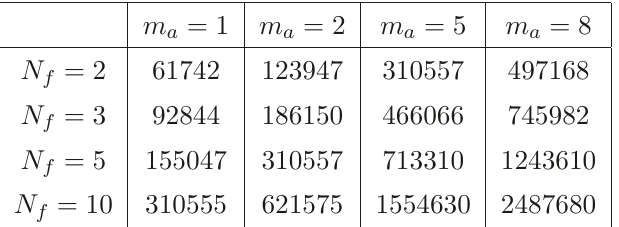
Table 2 . The free energies correspond to the confinement solution.